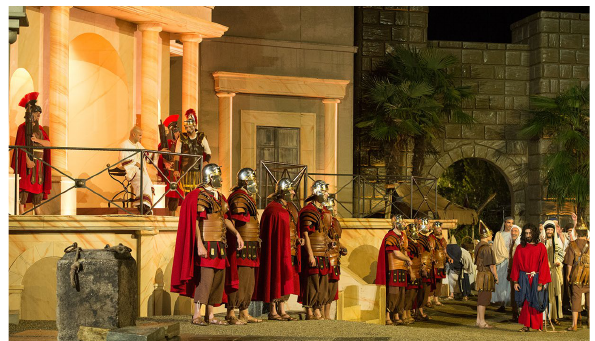
Figure 2 . Scenography of a Cattedra with actors. © Foto Perini